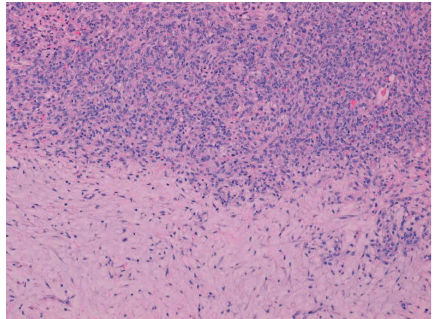
Figure 4: (100x, H&E) Hypercellular and hypocellular areas with